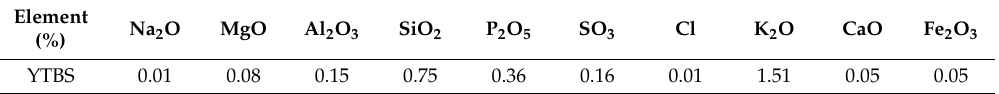
Table 3. X ‐ ray fluorescence spectrometry (XRF) of YTBS residue adsorbent.